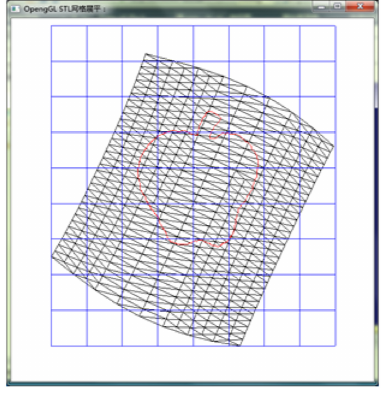
Figure 8. Regional square grid of the planar mesh